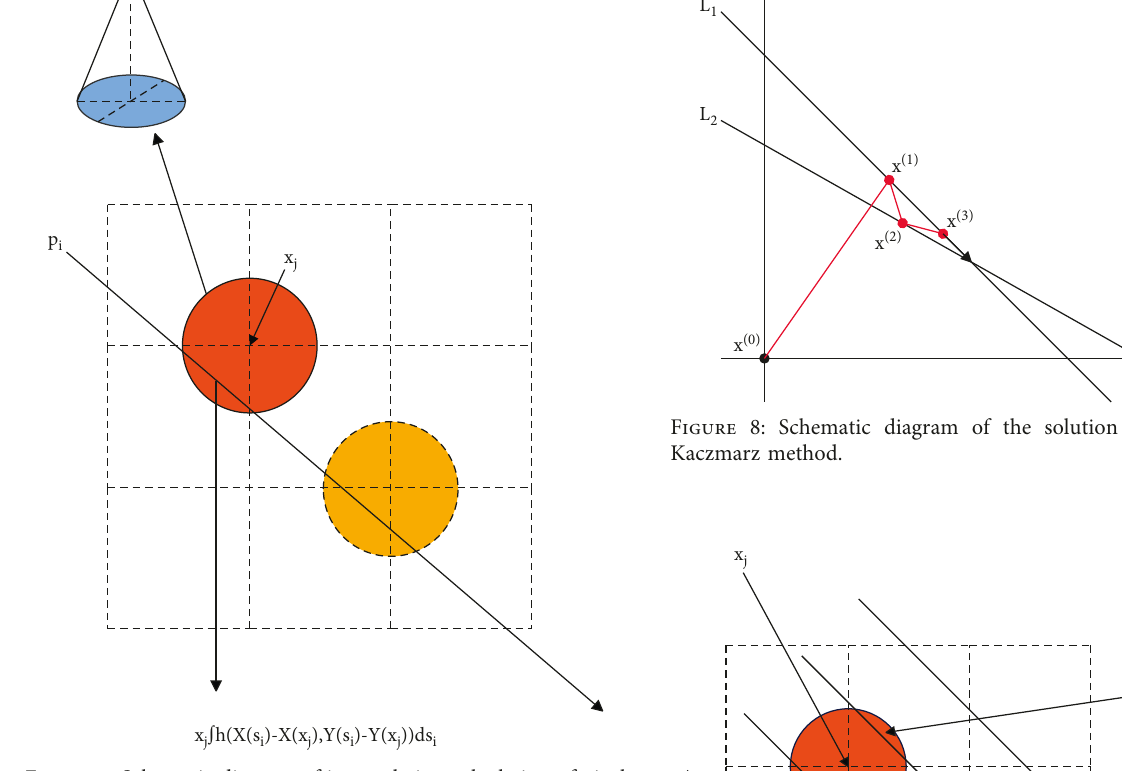
Figure 7: Schematic diagram of interpolation calculation of pixel x p j and ray i .